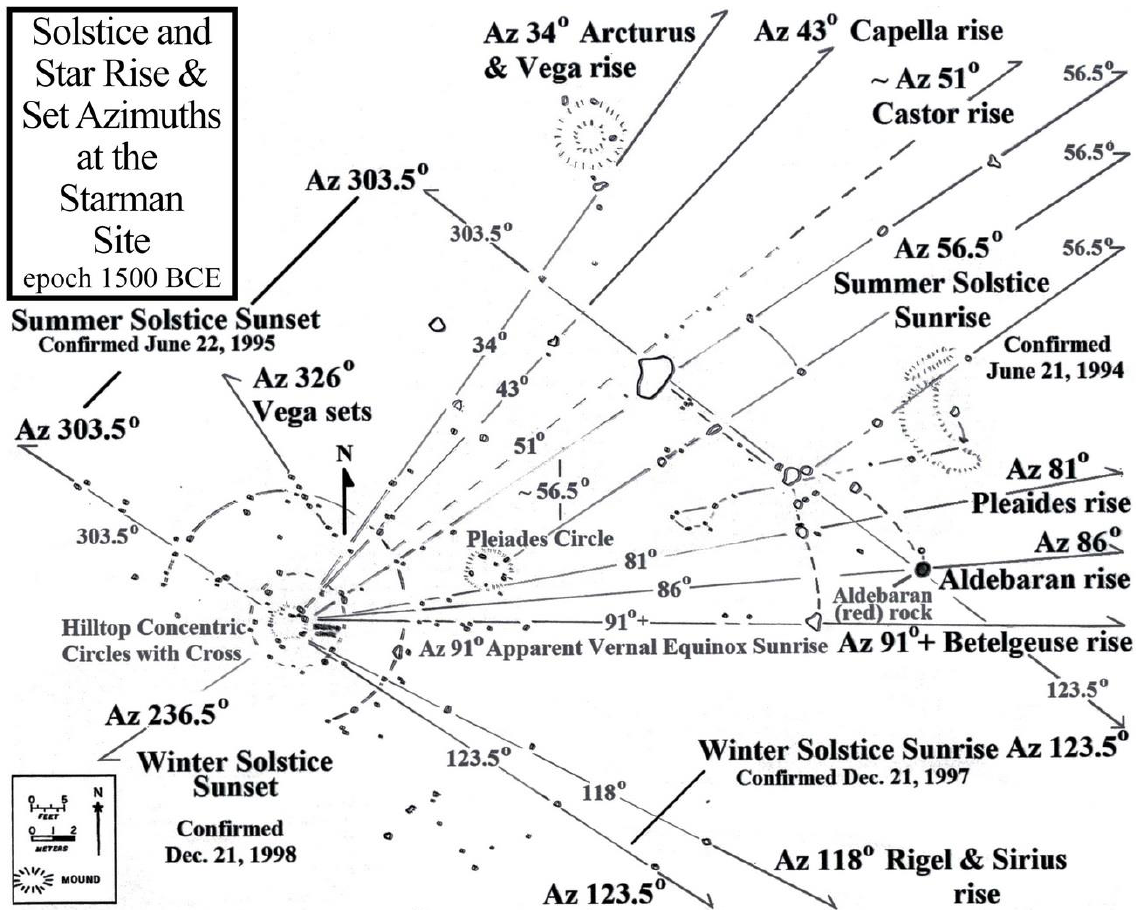
Figure 17. Map of the Starman site showing all the rocks mapped on the site (see Figures 2 and 14) together with the alignments of spaced rock identified for the solstice rise and set azimuths and the stellar heliacal rise azimuths observed from the hilltop circle ca. 1500